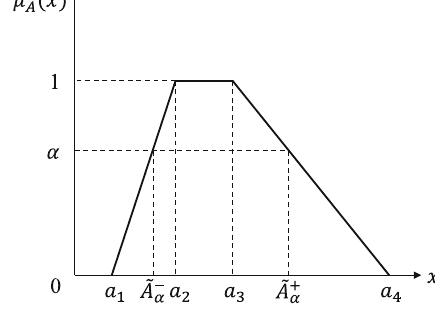
Fig. 2 A TrFN ˜ A = ( a 1 , a 2 , a 3 , a 4 ) and its α